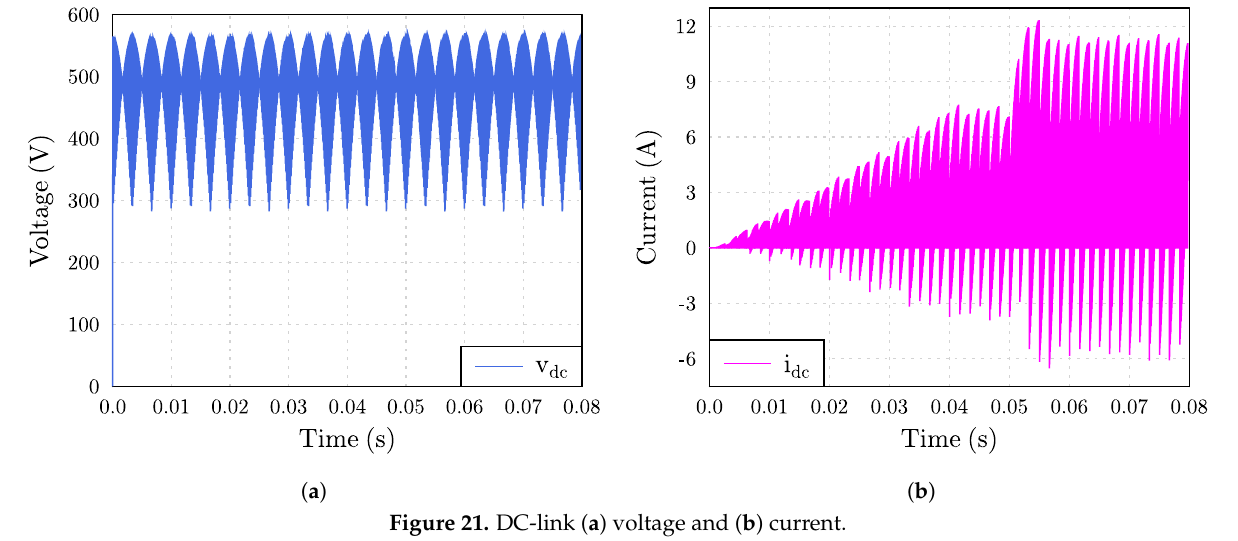
Figure 21. DC-link ( a ) voltage and ( b ) current. The output line and phase voltages at the IMC output are presented in Figures 22 and 23, respectively. For this simulation, the same RL load used previously in Section 4.1 was connected in the IMC output.